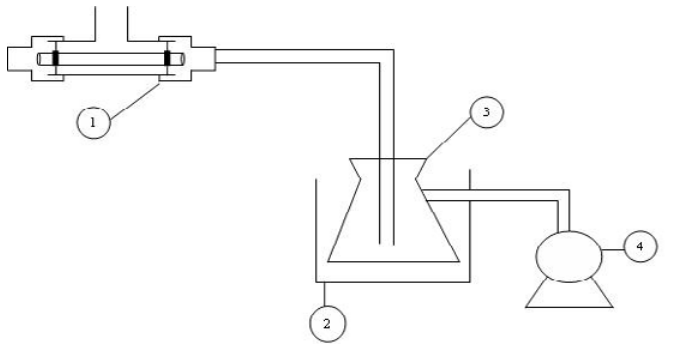
Fig. 2 represents the schematic diagram of the model domain used in the simulation. A feed solution containing a mixture of 5 wt. % UDMH and 95 wt. % water flows tangentially through the upper side of the membrane system (z=0) and exits at z=L.